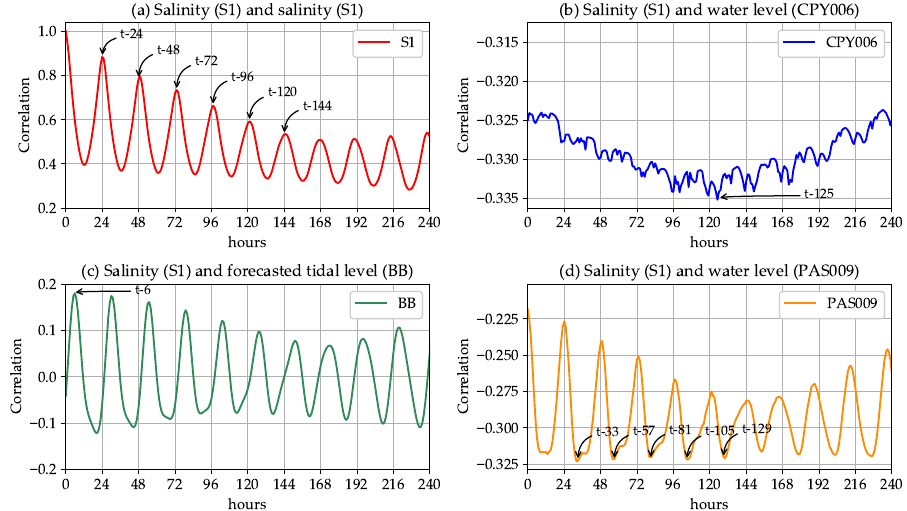
Figure 2. The cross-correlations between S1 and various variables: ( a ) the auto-correlation of S1; ( b ) the cross-correlation between S1 and CPY006; ( c ) the cross-correlation between S1 and BB; and ( d ) the cross-correlation between S1 and